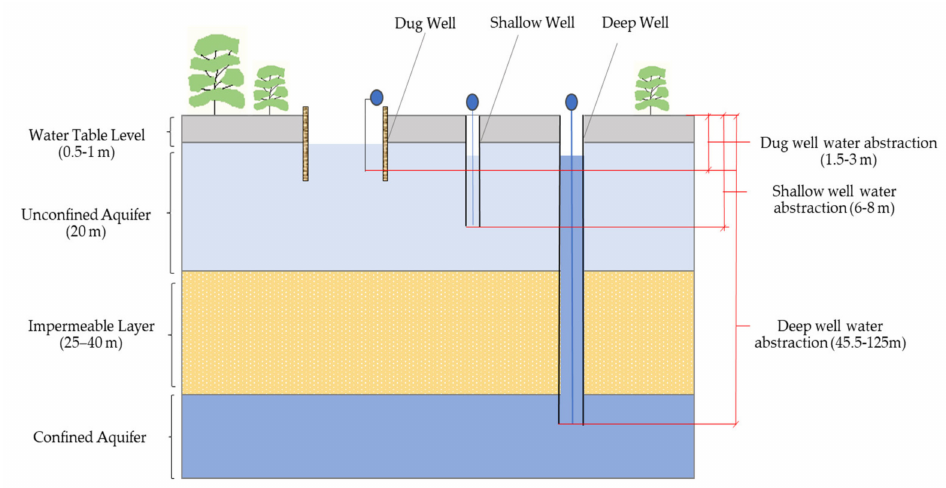
Figure 2. Well types, aquifer depth, and aquifer source in Bantul